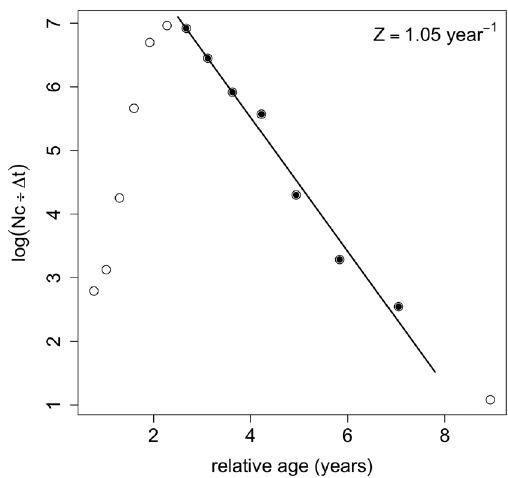
Figure 4 - Total mortality (Z) estimated to U. cordatus at Iguape (SP).